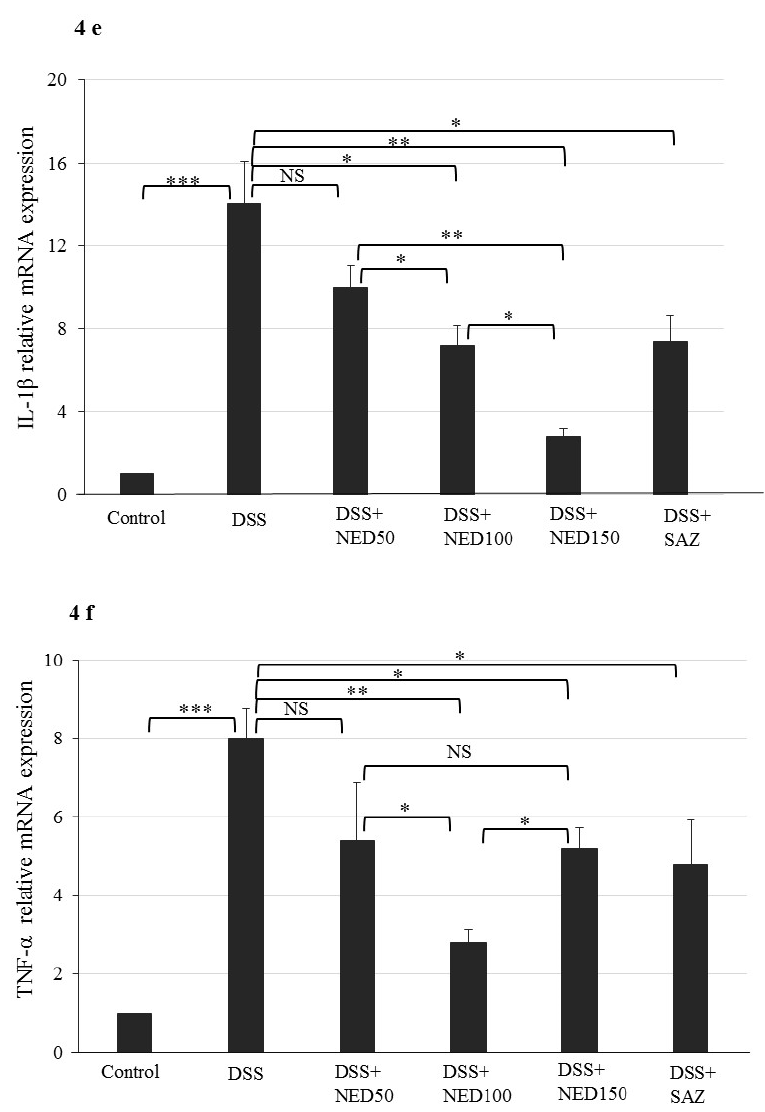
Figure 4. E ff ect of NED on proinflammatory cytokine protein and mRNA expression. NED-treatment, at 100 and 150 mg / kg, significantly inhibited the DSS-induced increase in concentrations of proinflammatory cytokines, at both the protein level (IL-6 ( a ), IL-1 β ( b ), and TNF- α ( c )) and mRNA expression levels (IL-6 ( d ), IL-1 β ( e ), and TNF- α ( f )) in DSS-induced colitis group. Data were obtained from n = 8 animals for ELISA and n = 6 animals for mRNA expression studies in each group and expressed as means ± SEM. *** p ≤ 0.001. ** p ≤ 0.01. * p ≤ 0.05. p values were obtained by one-way ANOVA followed by Tukey’s multiple comparison test using SPSS software. p ≤ 0.05 is considered statistically significant, and NS indicates not significant.